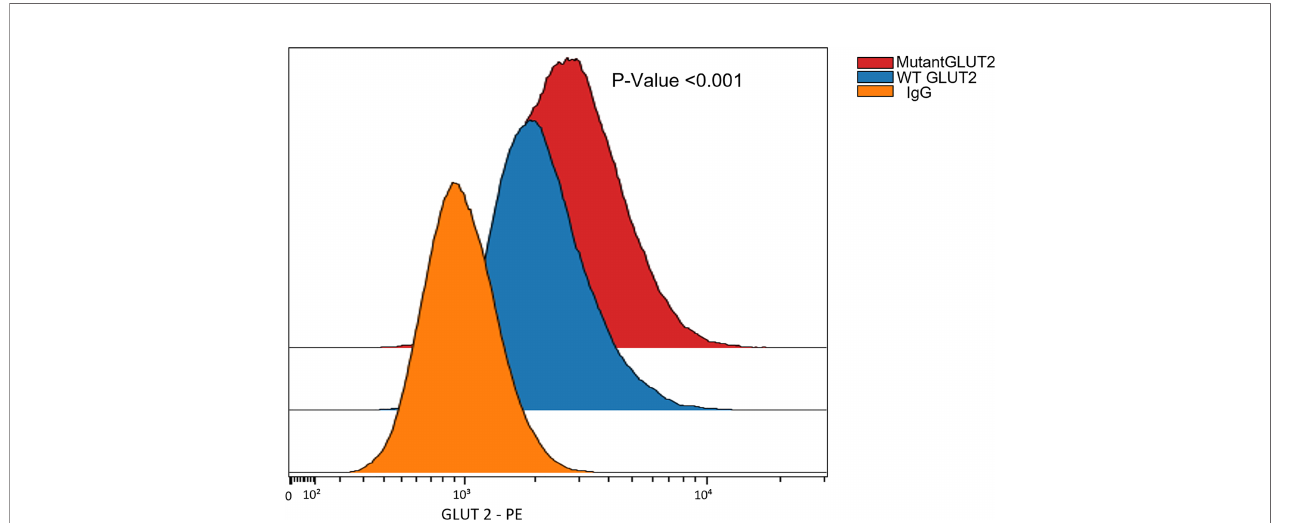
FIGURE 5 | Flow cytometry to assess the expression of GLUT2 protein in WT and mutant HEK293T cells. The expression of GLUT2 was signi fi cantly increased in the mutant cells. P-Value < 0.001 using nonparametric Mann-Whitney